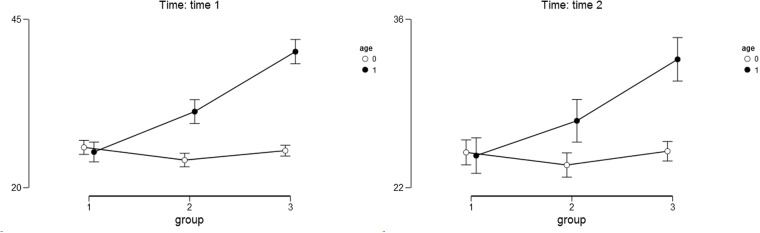
Descriptive statistics for self-esteem as the outcome variable. Age – 0 stands for younger children and 1 stands for older children. Group – 1 stands for control group; 2 stands for placebo group; 3 stands for narrative group. Error bars represent the 95% CI of a mean.